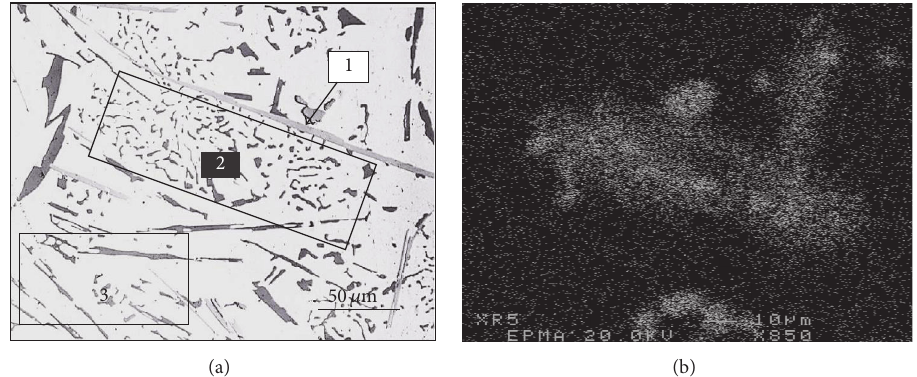
Figure 5: (a) Optical microstructure of alloy II (containing 103ppm Sr and 53 ppm P): (1) 𝛽 -Fe; (2) modified Si particles; (3) unmodified Si particles. (b) X-ray image of Sr distribution in a similar area to that marked (2) in (a).